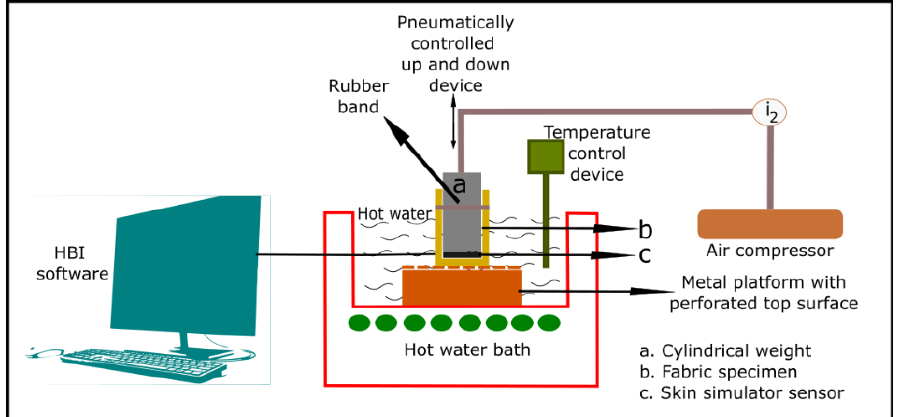
Figure 6. Thermal protective performance evaluating tester under hot water immersion with com- pression exposure.